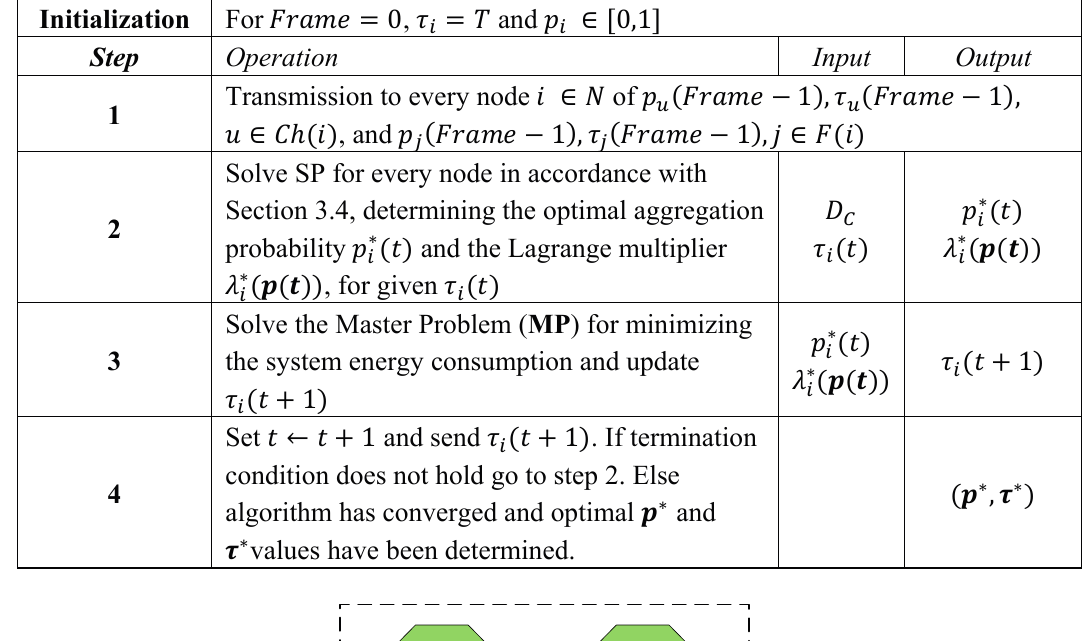
Table 1. Operation of aggregation-based energy management (AEM) algorithm.